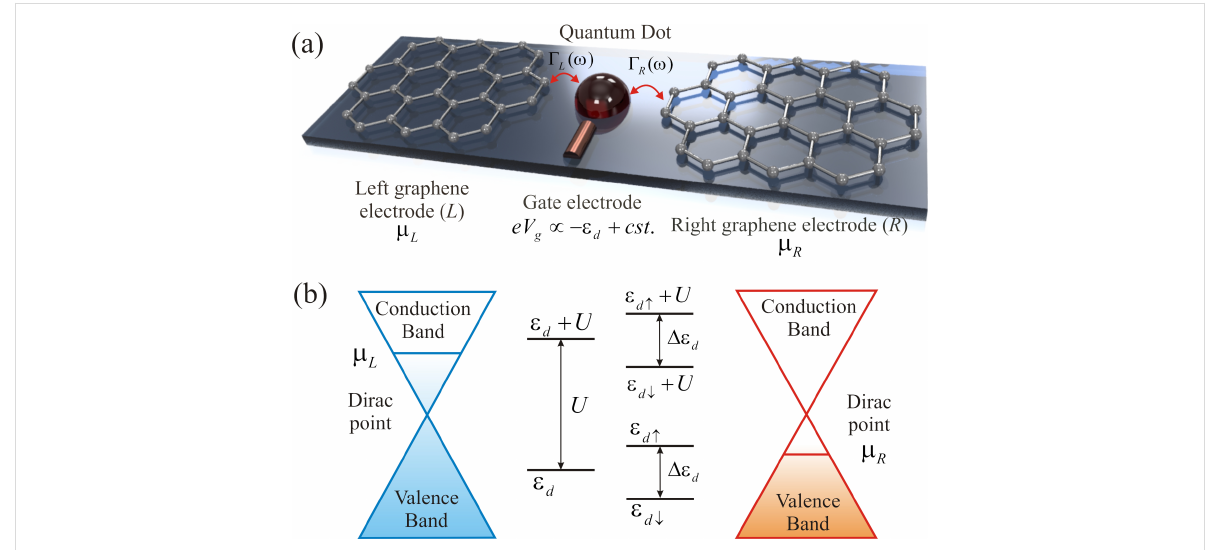
Figure 1: (a) Schematic picture of a QD coupled to pure monolayer graphene electrodes at its left ( L ) and right ( R ) sides with different chemical potential ( μ L and μ R ). Γ α ( ω ) represents the coupling strength between the QD and the α graphene electrode. The spin-independent QD energy level ε d can be modulated by the gate voltage V g at the gate electrode. (b) Schematic representation of the energy level diagram of the QD. The energy levels are shifted by the Coulomb energy ( U ). The applied magnetic field ( B ) leads to a splitting of the discrete energy